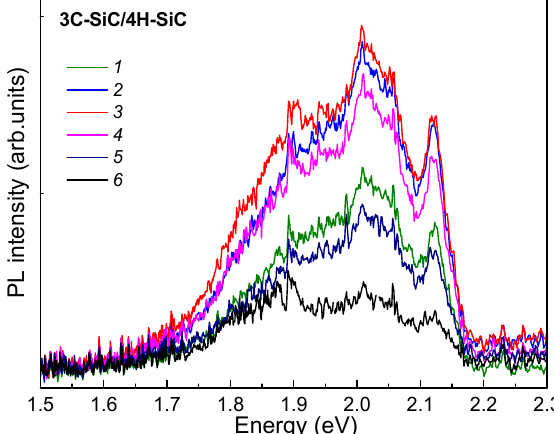
Figure 5. PL spectra of epitaxial 3 C -SiC samples after various irradiation doses, 10 15 cm − 2 : (1) 0, (2) 1, (3) 2, (4) 3, (5) 4, (6) 5.